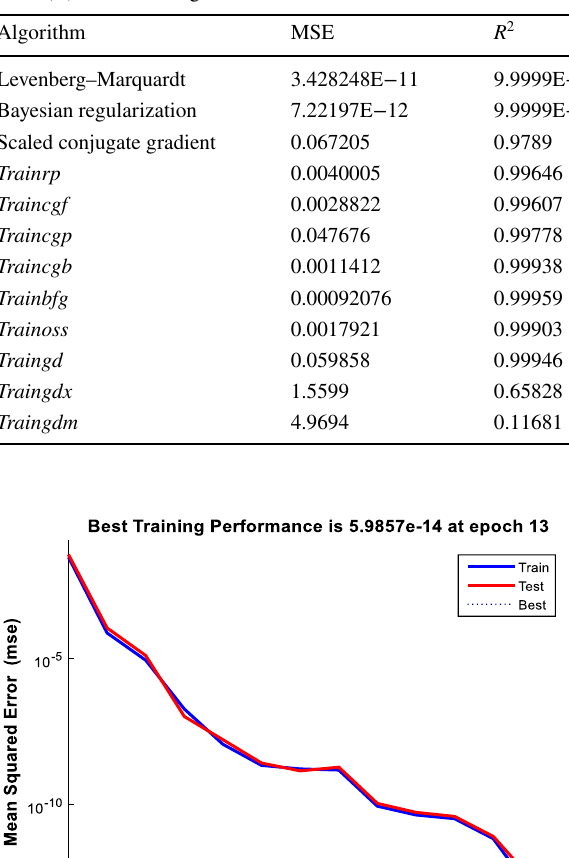
Table 9 Performance of different ANN models in estimation of vana- dium (V) removal using LAC